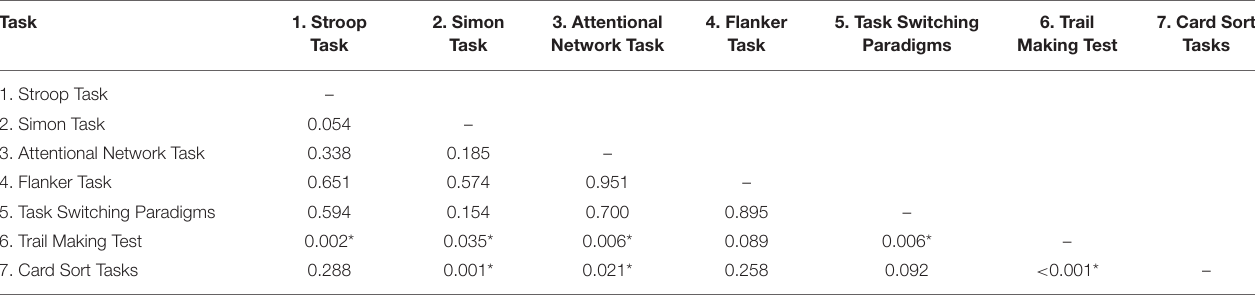
TABLE 1 | p -values from subgroup analyses comparing pairs of accuracy effect sizes from incongruent trials.